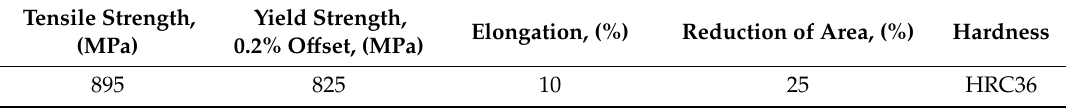
Table 2. Mechanical properties of Ti-6Al-4V.